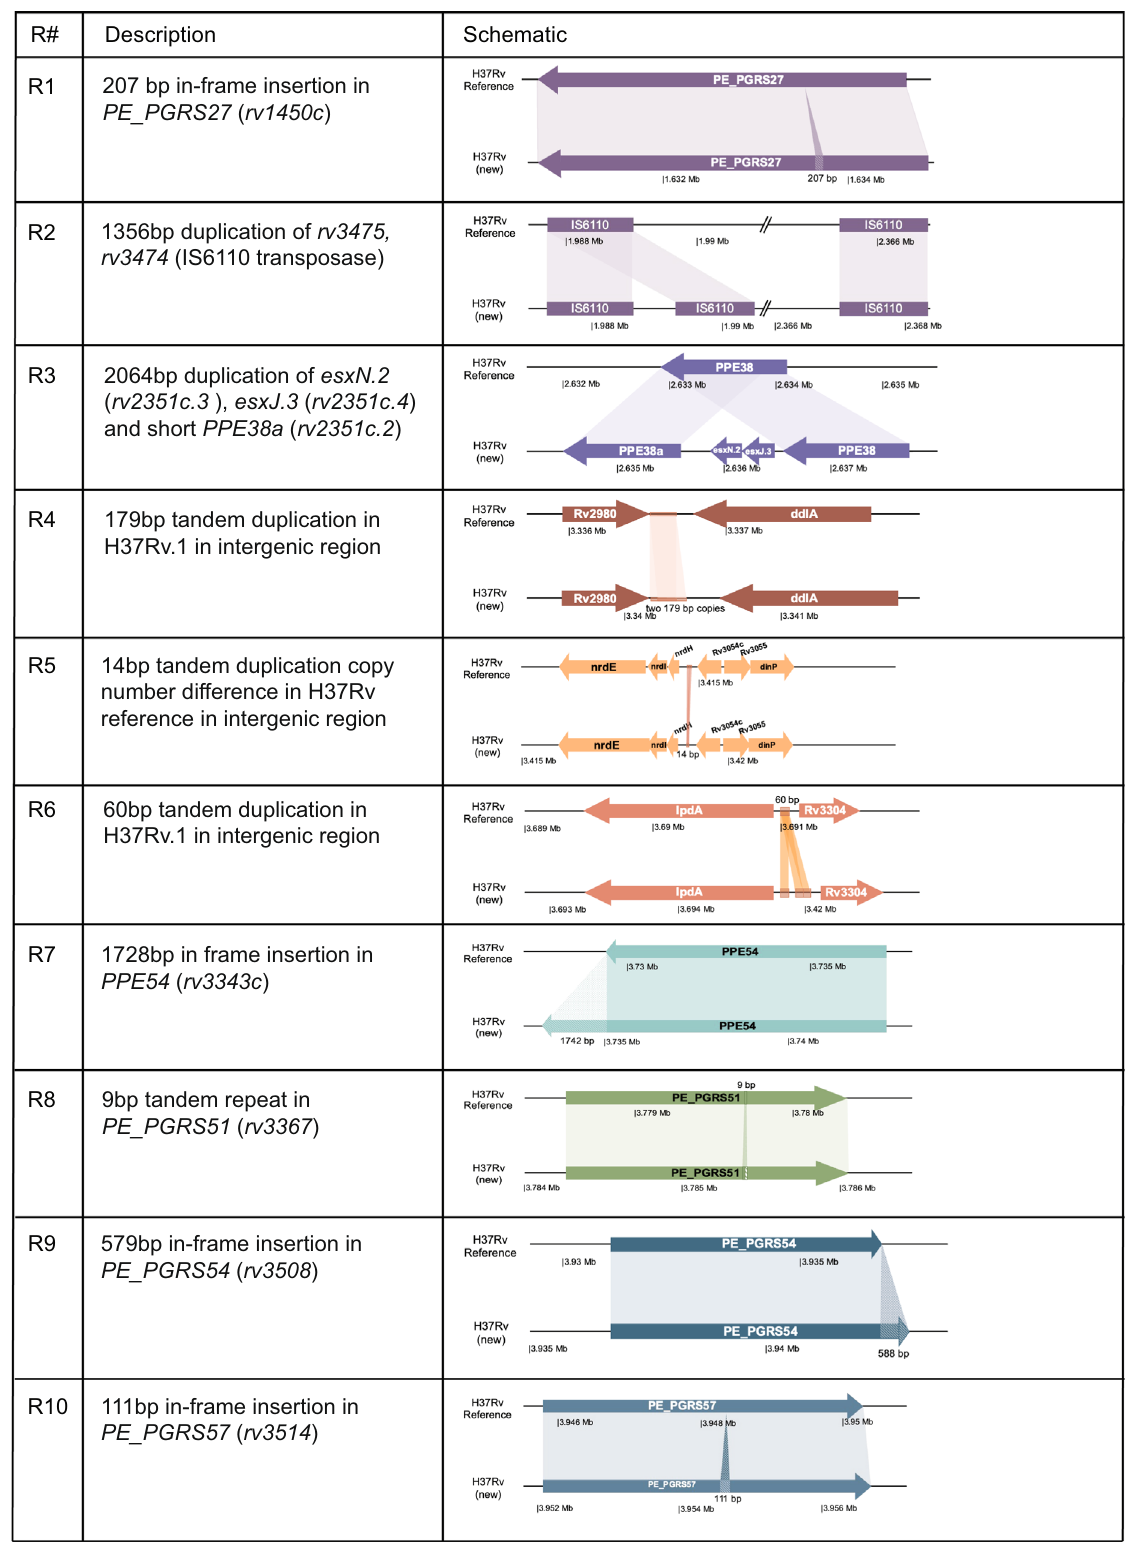
Fig.2|IdentifyingandvalidatingRegionsofdifference. Descriptionofthe10regionsofdifferenceidenti fi